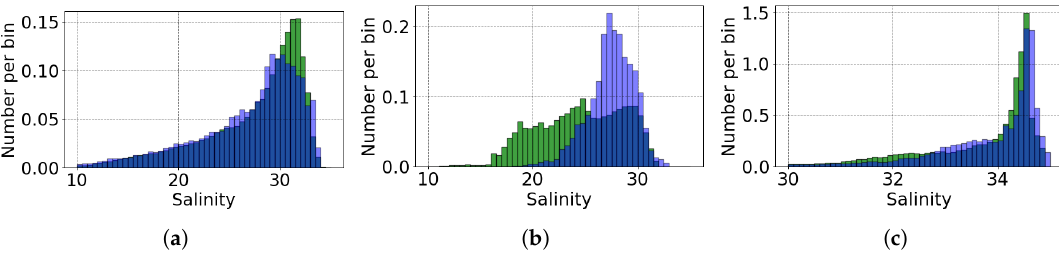
Figure 13. Distribution of salinity in measurements from the three ferry lines (blue) and the model (green). Ferries: ( a ) Cuxhaven–Helgoland; ( b ) Büsum–Helgoland; and ( c ) Cuxhaven–Immingham. Table 3. Comparison of salinity (S), temperature (T), and density ( ρ ) between FerryBox and FESOM-C. RMSE, Root Mean Square Error of anomalies. The numbers in brackets are based on absolute values. FerryBox (Operation Area) Number of Measurements Number of Transects S, RMSE T,